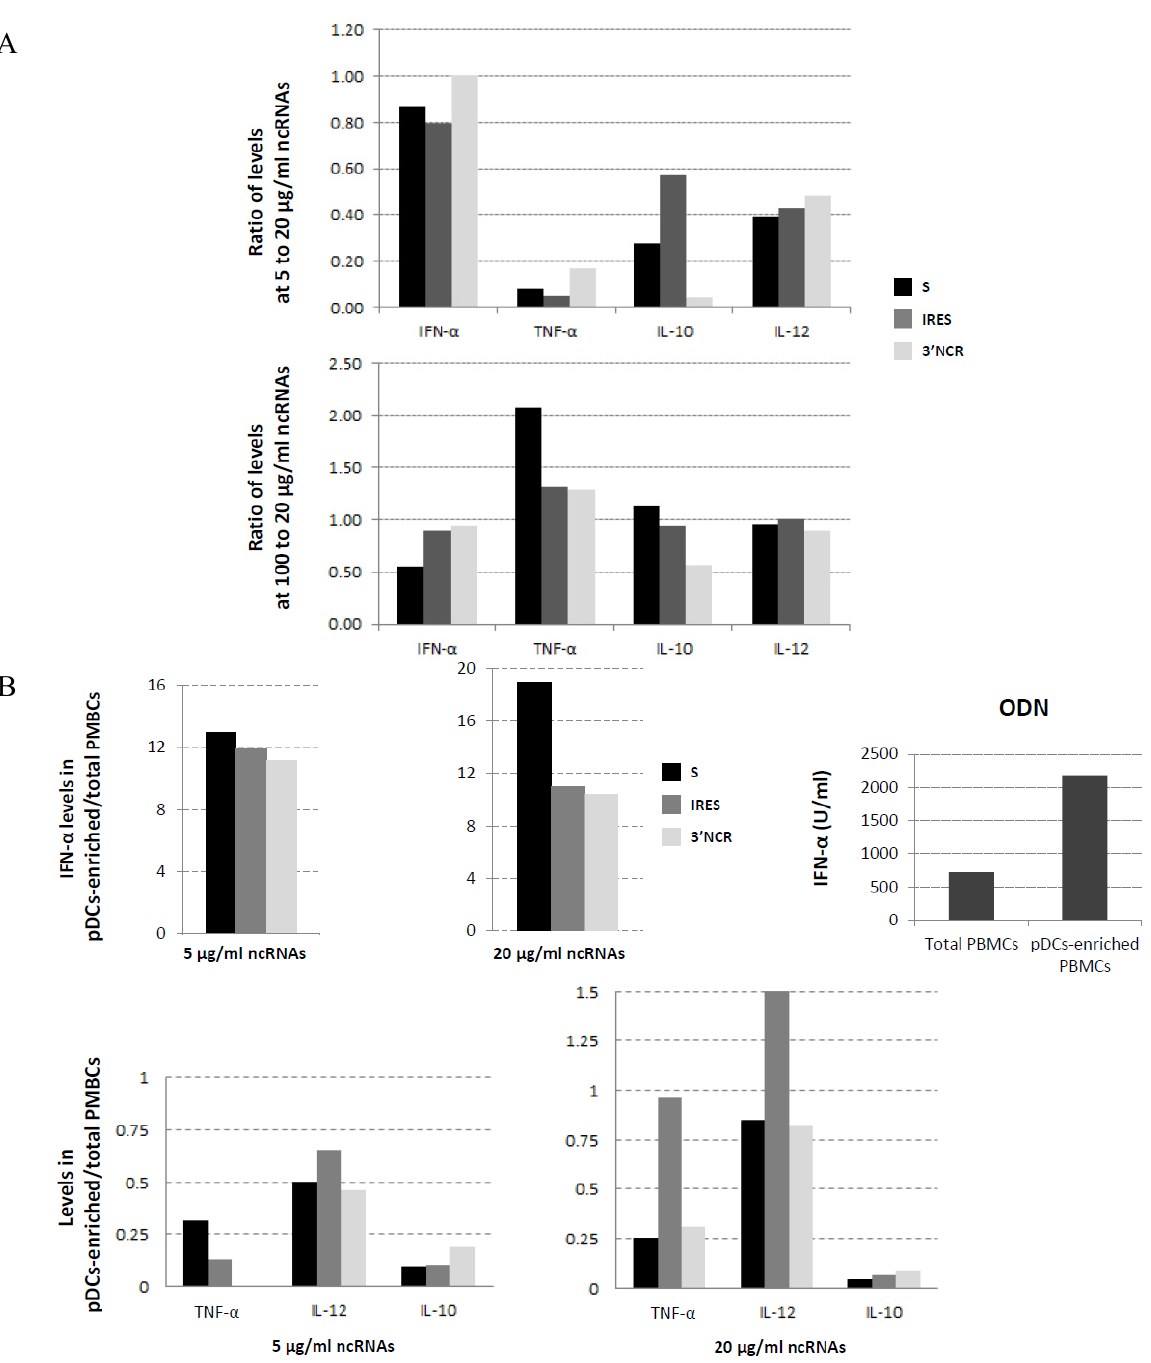
Figure 5. Effect of ncRNA dosage on cytokine induction in total swine PBMCs or after pDCs-enrichment. ( A ). PBMCs were transfected with S, IRES or 3 ′ NCR at 5, 20 or 100 μ g/mL and the IFN- α , TNF- α , IL10 and IL12 levels were measured by ELISA. The data shown are the ratios of the values obtained at 5 or 100 μ g/mL for the indicated cytokine relative to those obtained at 20 μ g/mL with the corresponding RNA; ( B ) Total PBMCs or